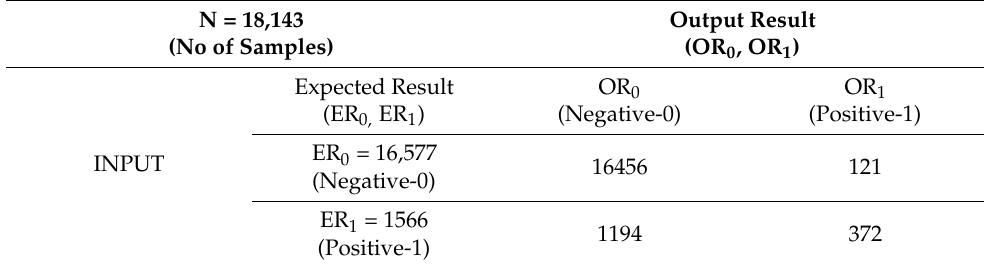
Table 4. DT Training Results.